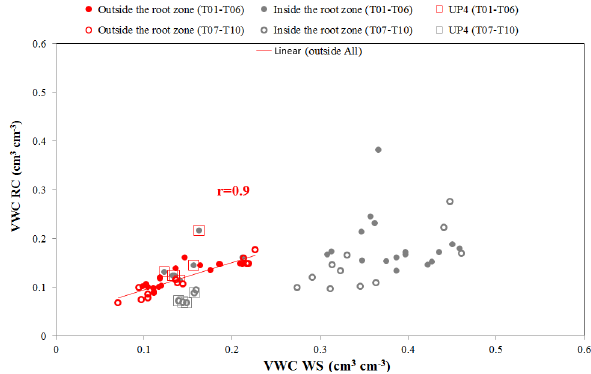
Figure 7. Relationship between matric potential and ER measured in the topsoil during the study period (T01–T10). Red and gray cir- cles indicate the data collected regularly outside and inside the root zone, respectively. Filled circles indicate the wet period (T01–T06) and open circles the dry period (T07–T10).